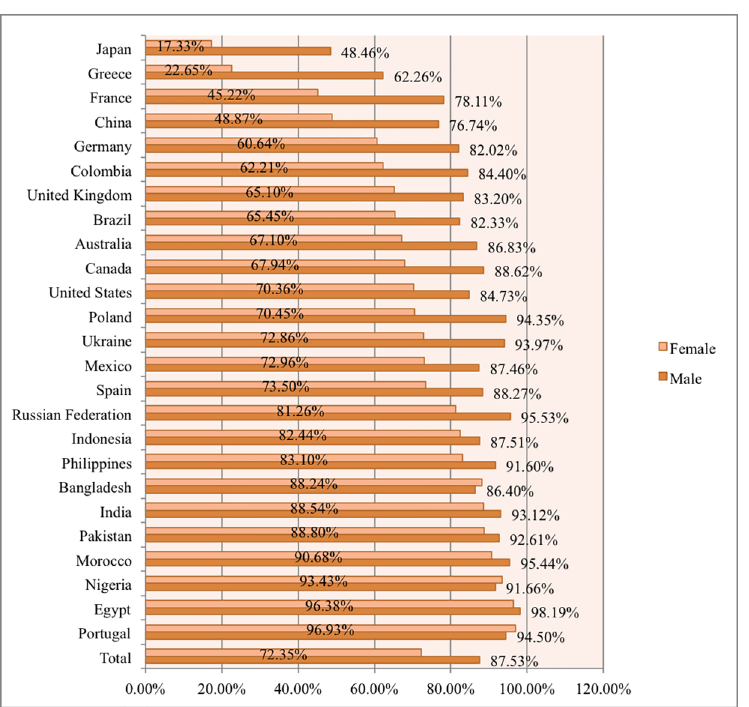
Fig 2. Percentage of all MOOC enrollees in each country who enrolled in one or more STEM MOOCs, by gender.